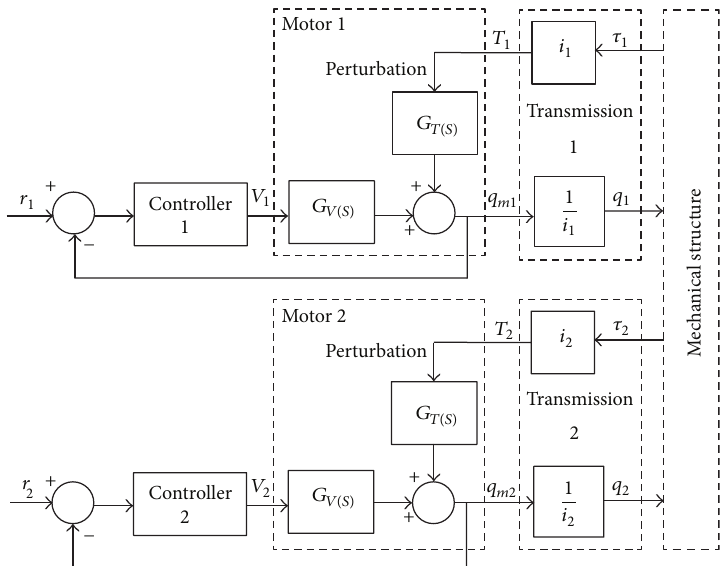
Figure 4: The refined control scheme of the tracking